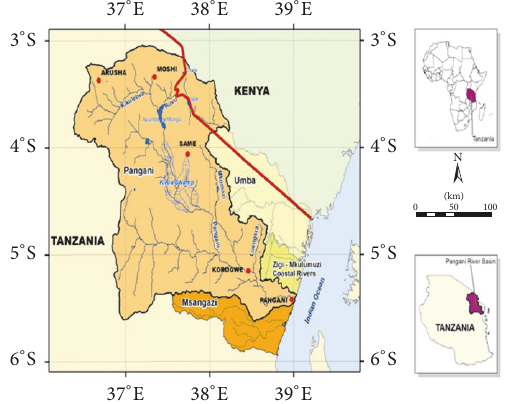
Figure 3: Pangani river basin [26].